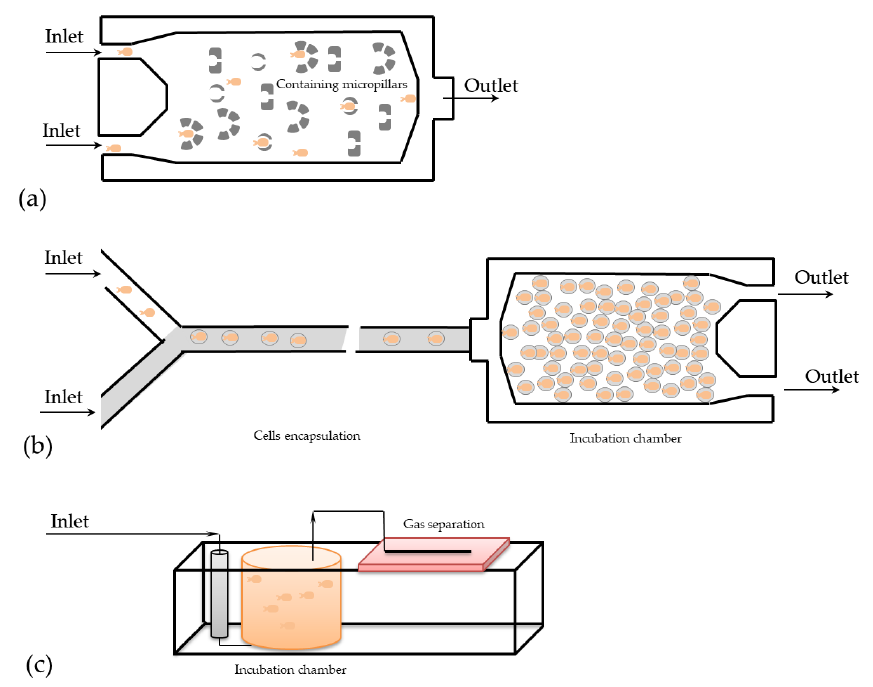
Figure 5. Schematic diagram for ( a ) microfluidics with different mechanical traps/pillars, ( b ) micro- fluidics for droplet formation, and ( c ) microfluidics with